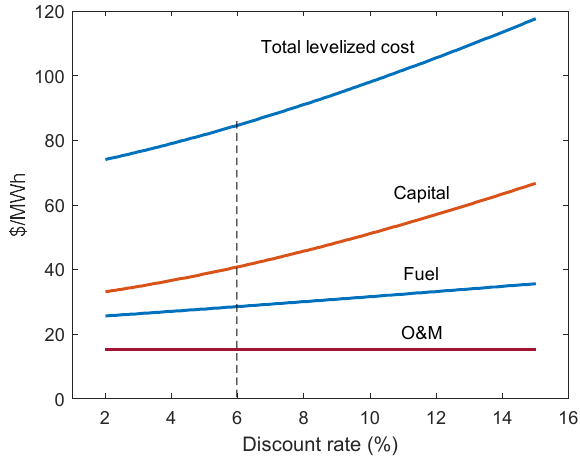
Figure 14. NB levelized electricity costs vs. discount rate.